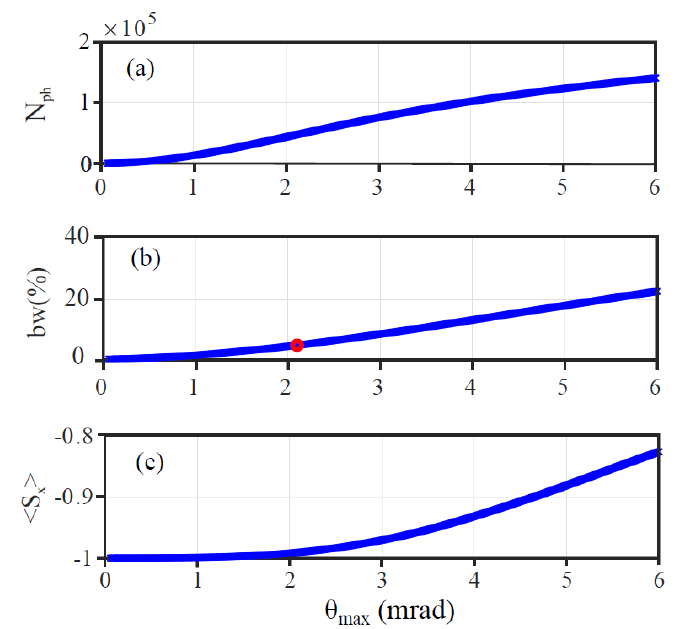
Figure 12. High energy case E e = 100 MeV. ( a ) Number scattered photons, ( b ) bandwidth and ( c ) average Stoke parameter as function of collimator angular aperture θ max .